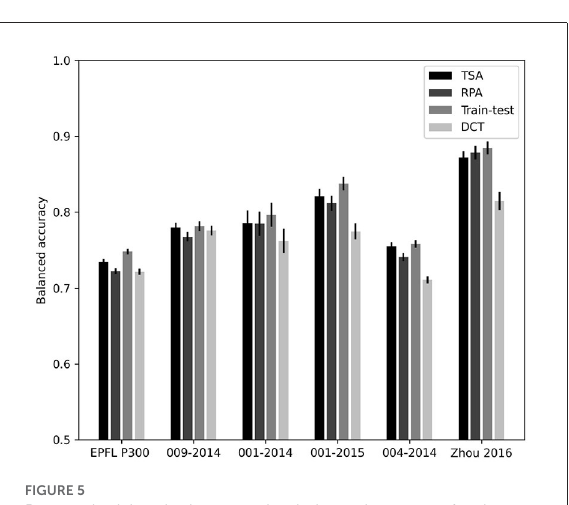
FIGURE5 Bar graph giving the inter-session balanced accuracy for the databases possessing multiple sessions.